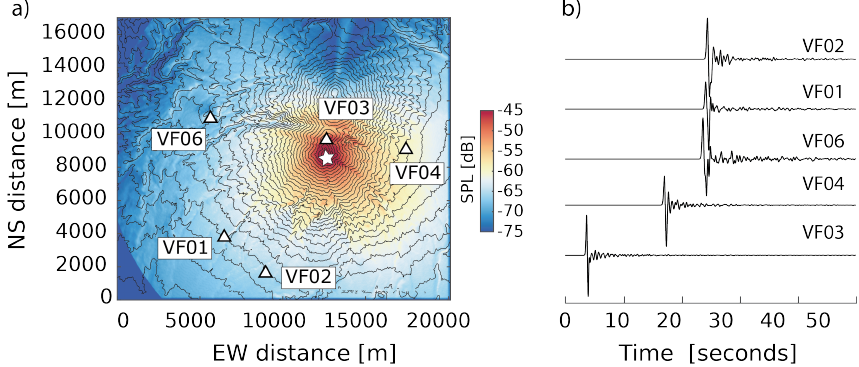
Figure 8. Numerical simulation of acoustic wavefield propagation at Fuego volcano (Guatemala): ( a ) distribution of Sound Pressure Level (i.e., acoustic wavefield intensity measured in decibels relative to background atmospheric pressure) around the source (white star); and ( b ) 3D Green’s Functions excited by a monopole located at the source position (white star) and recorded at different stations across a local infrasound network (station positions on the volcano indicated in ( a )).